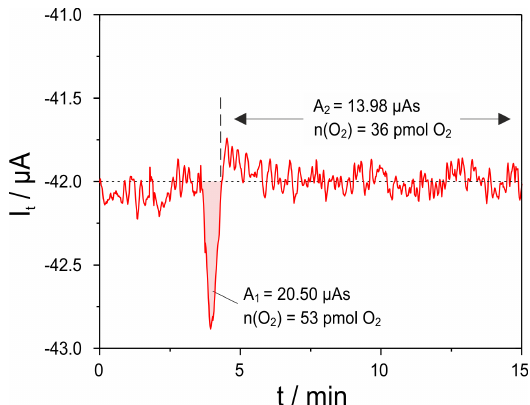
Figure 6. Oxygen titration peak measured with cell two of the setup given in Fig. 1 at U P = − 300mV; sample: 8mol-% YSZ; sample temperature 650 ◦ C; sample polarization 25mV for 60s; flow rate 50mLmin − 1 .